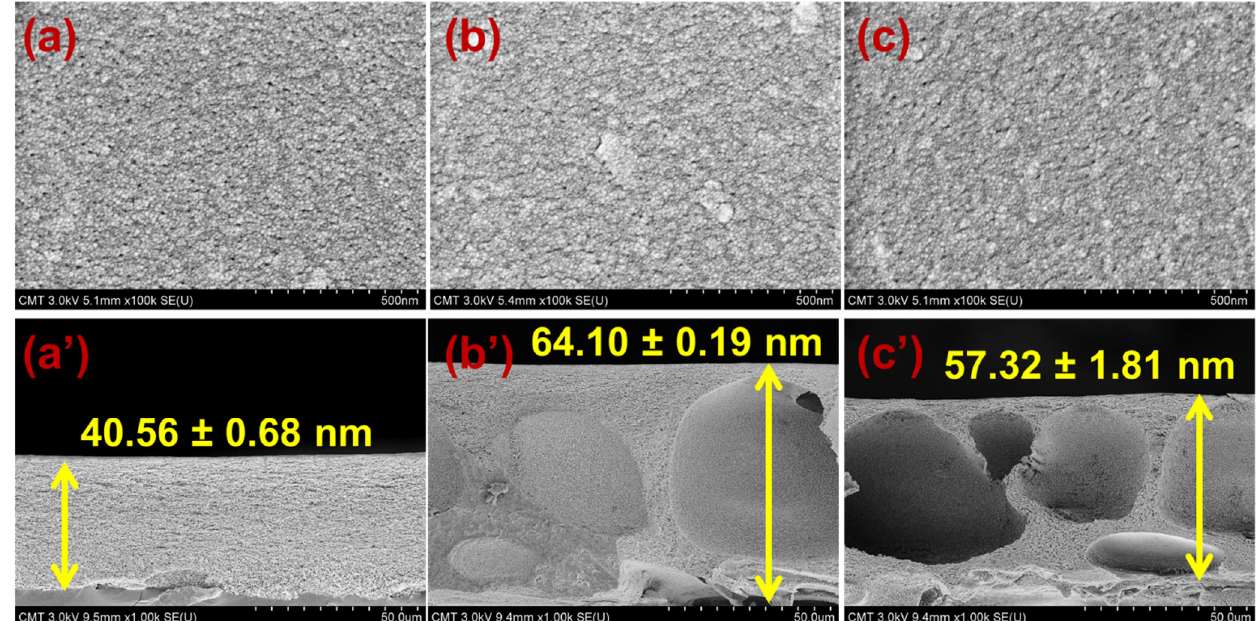
Figure 2. Surface and cross-sectional FESEM images of the membranes; ( a , a’ ) CA; ( b , b’ ) CA NA-MMT ; and ( c , c’ ) CA O-MMT .